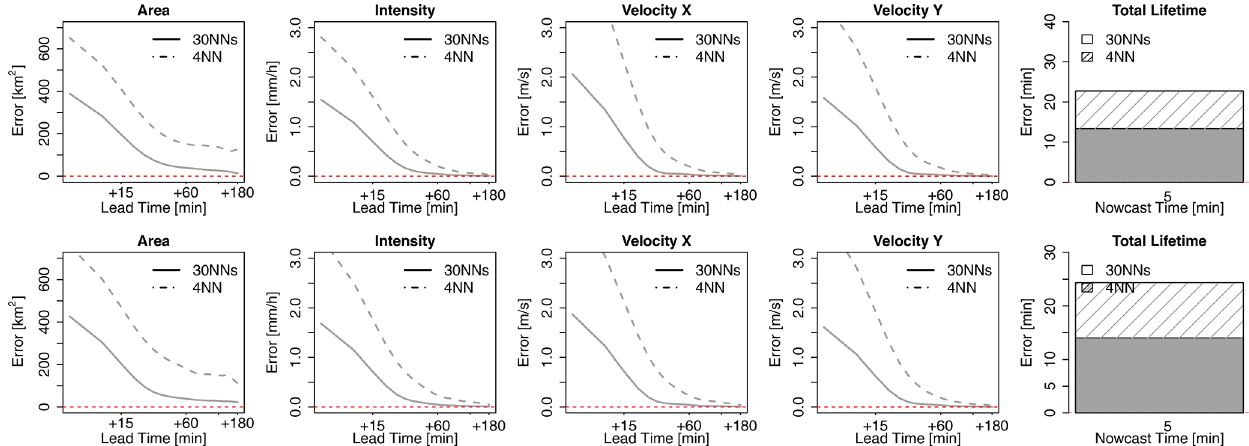
Figure 14. Median CRPS error over the 110 events for each of the target variables nowcasted from 4-NN deterministic (in dashed lines) and 30NNs probabilistic (in solid lines) applications for both target- (upper row) and storm-based (lower row) approaches. The results shown here are from the “unmatched storms” when the nowcast time is